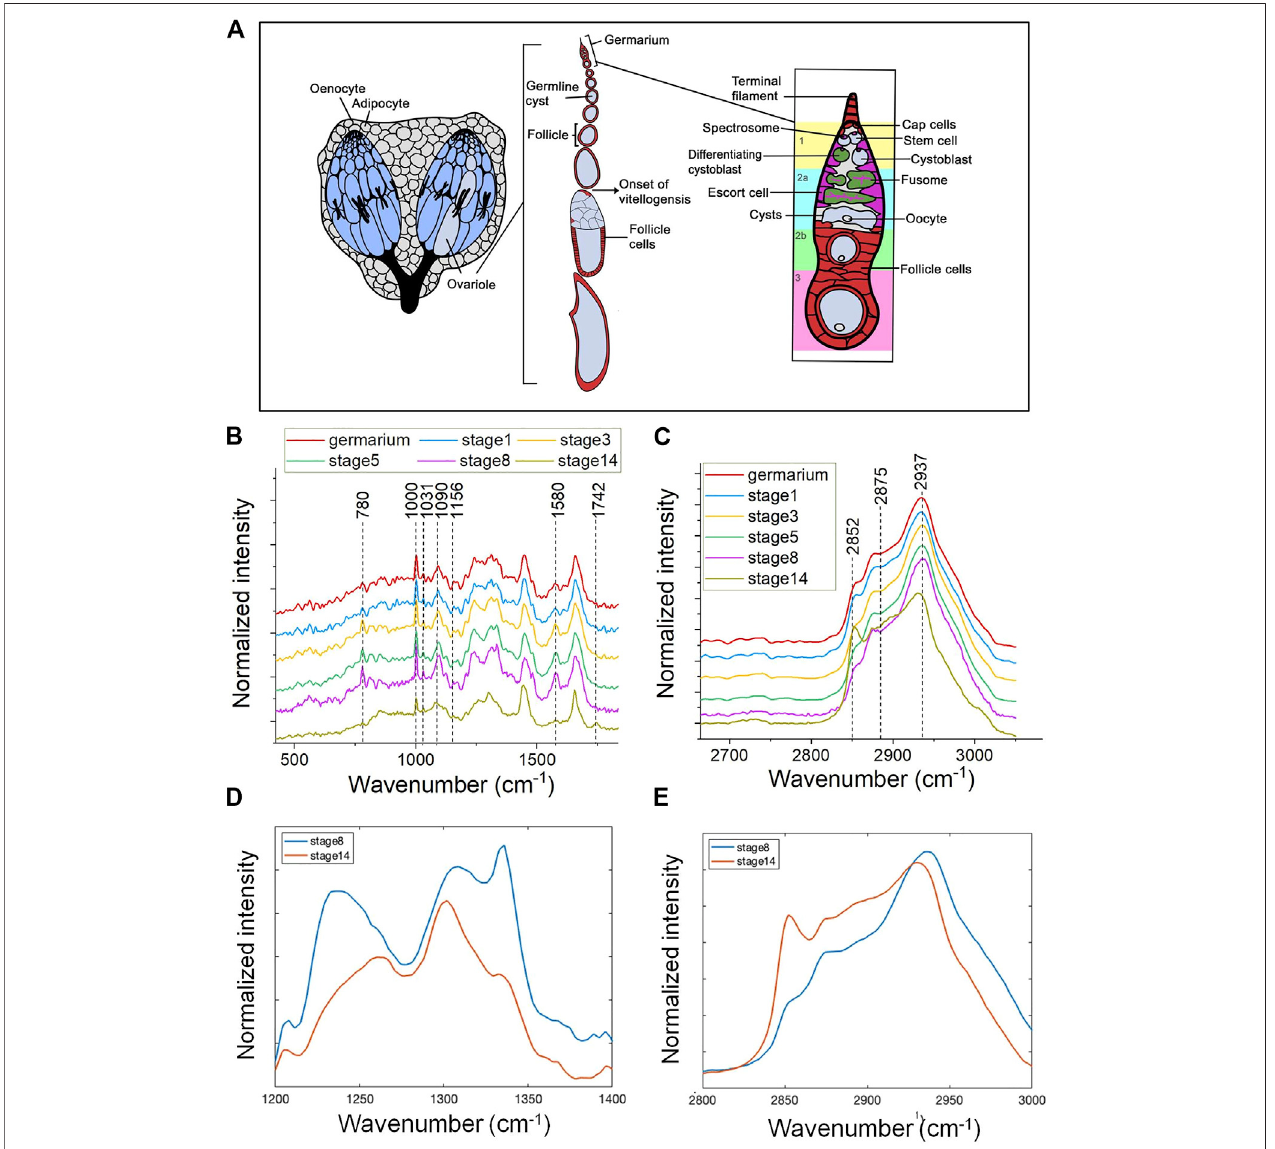
FIGURE 1 | Spontaneous Raman spectra of Drosophila ovaries revealing molecular changes during oogensis. (A) A diagrammatic illustration of the structure of adult ovary. The Drosophila ovary consists of two lobes that are connected by a common oviduct. Each lobe is composited of approximately 14 – 16 ovarioles. Each ovariole harbors an anterior localized germarium and following older follicles that develop through 14 distinct stages. Within the germarium, germline stem cells (GSCs) are surrounded by cap cells and escort cells, two major cellular components of the somatic niche. One GSC generates two daughter cells through unsymmetric mitosis, one is GSC and the other one is cystoblast. Each cystoblast divides four additional times to form 16-cell germline cysts consisted of nurse cells (nc) and an oocyte(oo).Folliclestemcells(FSC)dividetoformprefolliclecells,whichsurroundthe16-cellgermlinecyst,andisolatethemfromthegermarium.Prefolliclecellsgiverise todifferentkinds ofspecialized folliclecells (fc) thatlocalized inan epithelial monolayer surrounding each cyst. Themature oocyteislocalized atthe posterior end ofeach ovariole. The fi ngerprint region (B) and CH stretching region (C) of mean Raman spectra ( n (cid:1) 10) of follicles at different developmental stages in 5-day female fl ies. (B) Compared with the mature oocyte, germarium and the developing follicles show a relatively high intensity of Raman peaks at 780 cm − 1 , 1,000 cm − 1 , and 1,580 cm − 1 and these peaks show a gradually higher intensity alongside the follicle maturation. There is a shape remodeling of amide III in the last stage of oogenesis (stage 14), which is different from the early stages. (C) A dramatically high intensity at 2,852 cm − 1 is shown in stage 14 oocytes and the peak position of stage 14 oocytes at 2,937 cm − 1 isrelativelyleft-shifted. (D) TheenlargedamideIIIregionand (E) CHstretchingregioncomparingtheRamanspectralshapefromstage8(blue)andstage14 (red) follicle. Early developing follicles (stage 8) showed more protein enriched, and mature eggs (stage 14) showed more likely lipid dominated.